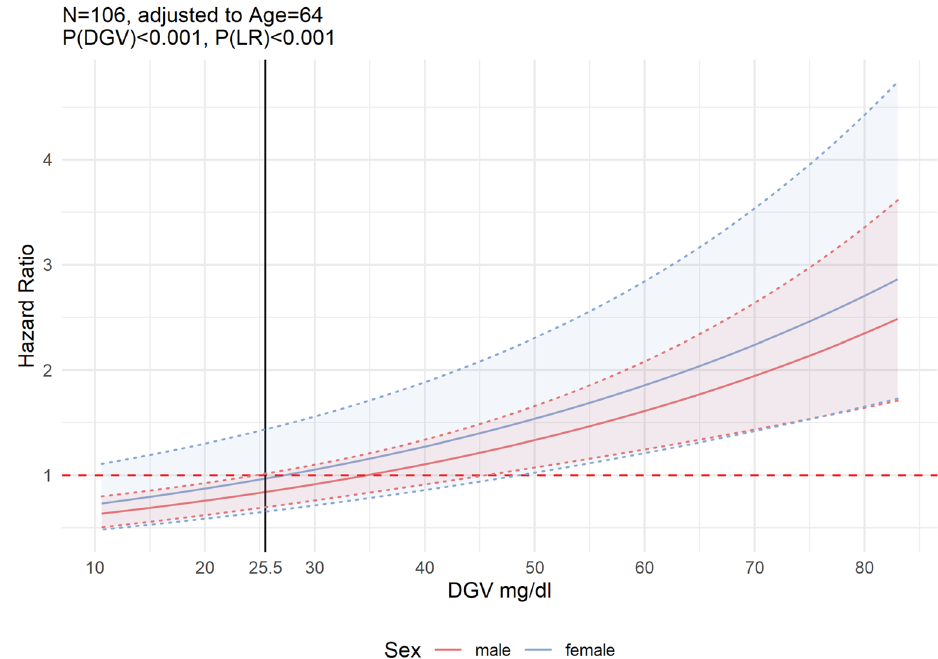
Figure 3. Relation between fatality risk and glucose variability. Continuous hazard ratios for fatality or non- survival were calculated by Cox proportional hazard models of daily glycaemic variability (DGV) adjusted for age and sex, including 95% CI for endpoint. The dashed red line notates a hazard ratio of 1.0, the solid black line the dichotomisation threshold, which we determined using a regression tree. The threshold of 25.5 mg/dl for DGV was used for our summary statistics (Tables 1 and 2), Kaplan–Meier curves (Fig. 4) and the adjusted DGV Cox proportional hazard model (Fig. 5).